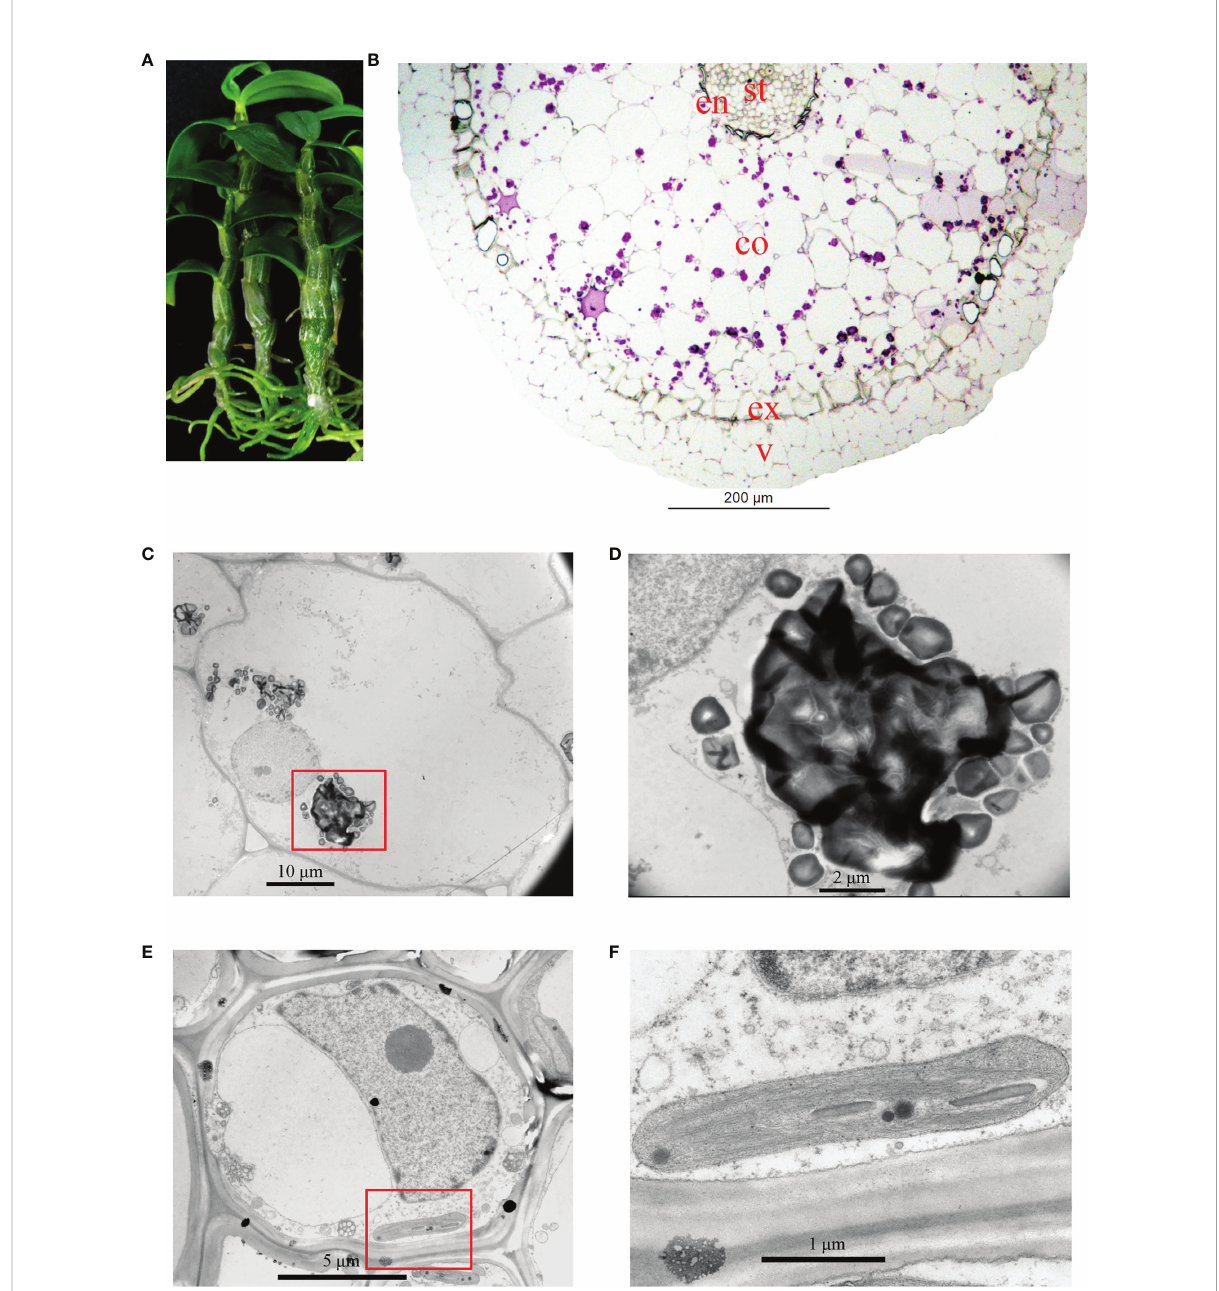
FIGURE 1 Analysis of the structure of in vitro Dendrobium of fi cinale plantlet roots. (A) The roots of plantlets are green (chlorophyllous). (B) Overview of the anatomical traits of roots in a transverse section. Root tissue was stained by PAS. St, stele; en, endodermis; co, cortex; ex, exodermis; v, velamen. (C) Transmission electron microscopic observations of cortex cell morphology. (D) Enlarged view of starch granules from (C) . (E) Morphology of a stele cell. (F) Enlarged view of a chloroplast from (E)